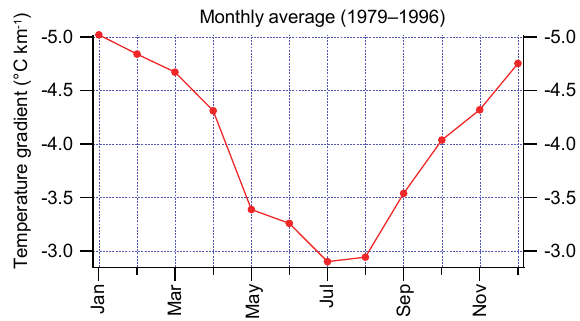
Figure 11. Temperature lapse rate from sea level to 850hPa level at Bellingshausen station (BE), King George Island, Antarctica. The data is shown as the monthly mean value of observation between 1979 and 1996 (SCAR Reference Antarctic Data for Environmental